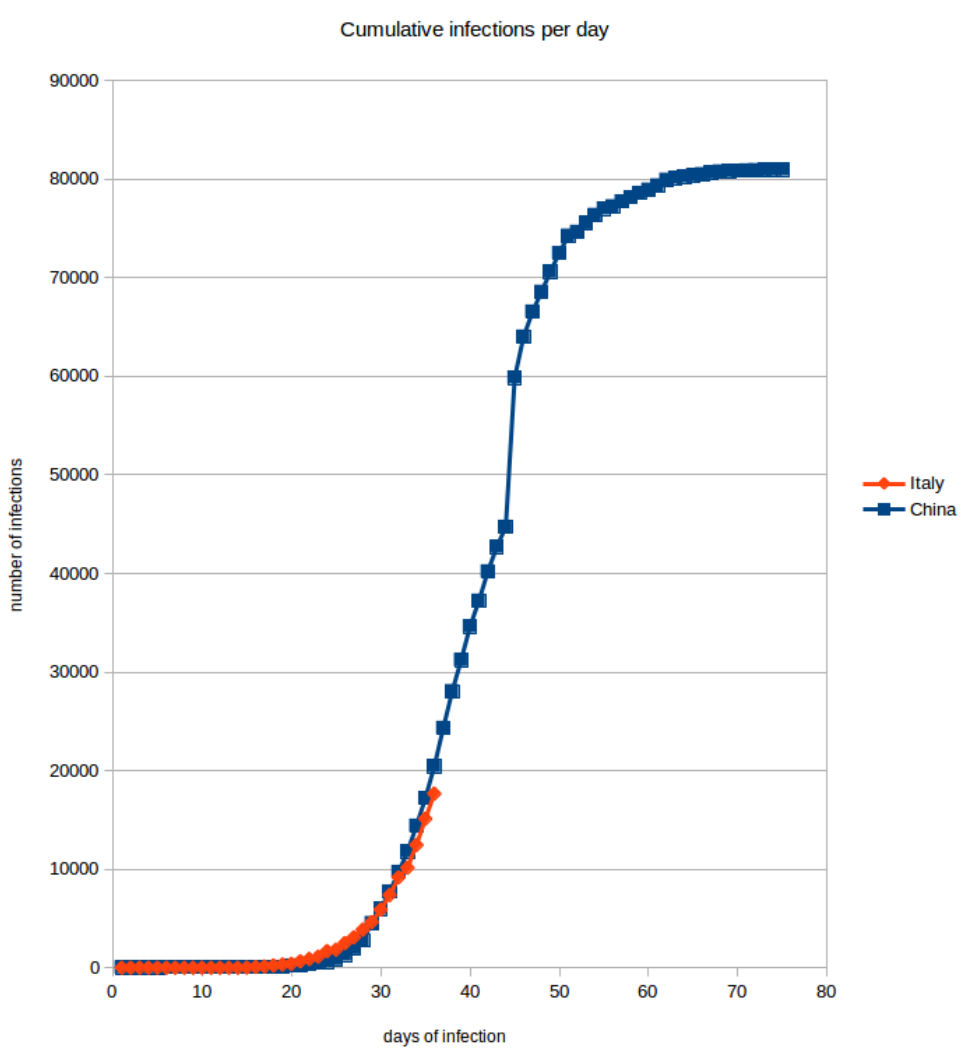
Figure 2. Here the two Italian and Chinese red zones (areas of maximal infection) are compared. On the X axis there are days and on the Y axis there are the total number of cases. The two curves are very similar showing that the initial trend of the infection follows an exponential growth, even though the Chinese government rapidly adopted stringent confinement measures. We can thus expect to observe the same initial infection evolution, before arriving to the logistic portion of the